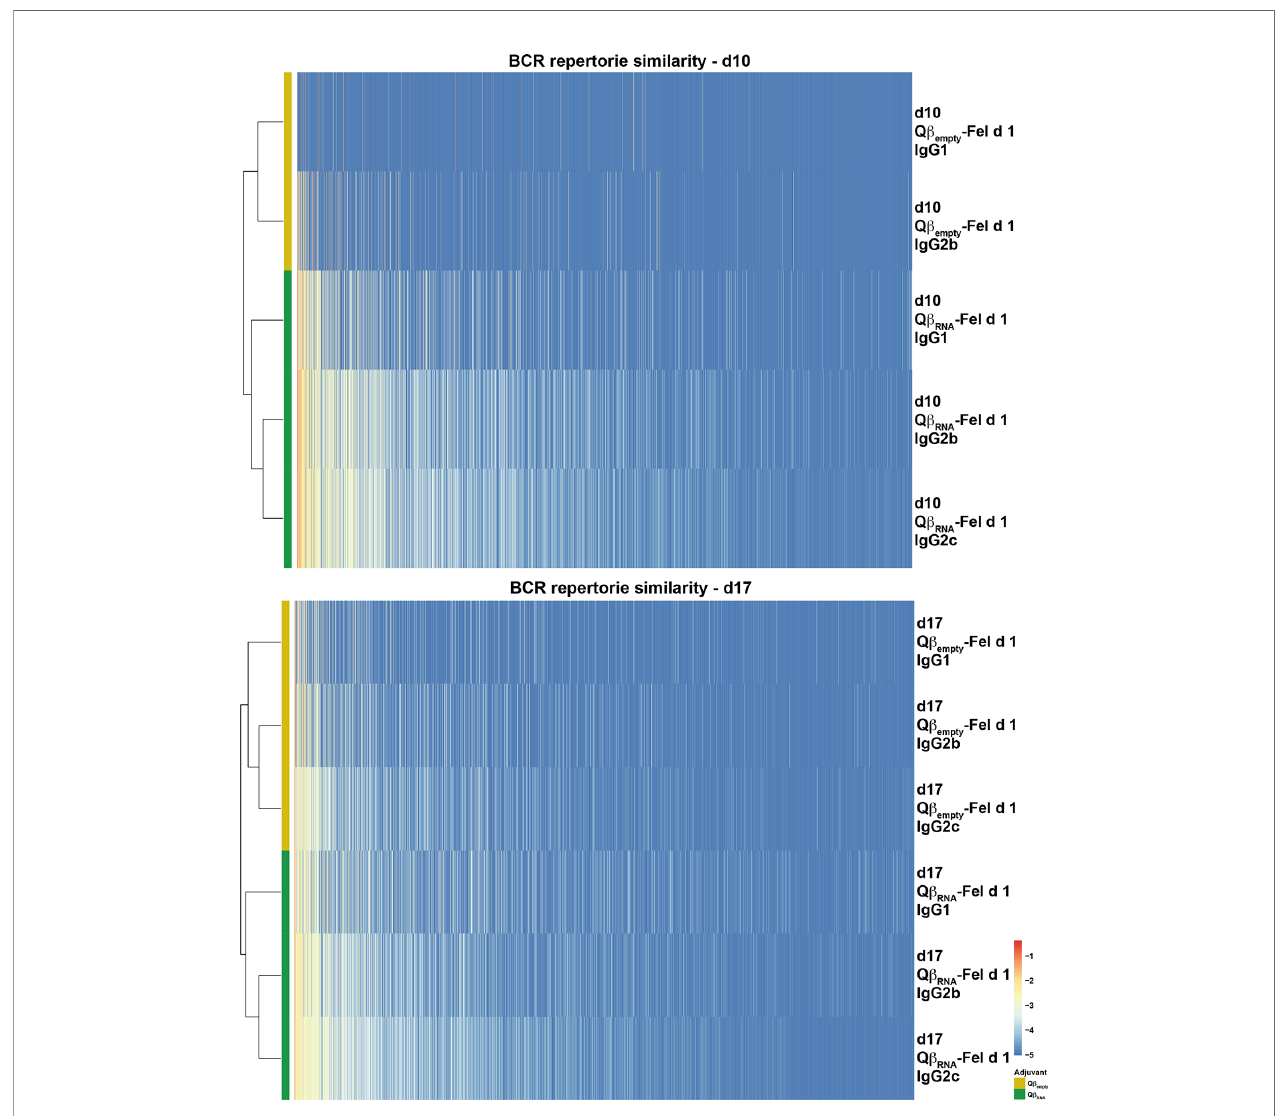
FIGURE 7 | Similarity of Fel d 1-speci fi c IgG BCR repertories at d10 and d17 after immunization. The CDR3 clonotypes were displayed, usage frequency was shown as each colored bar, and the phylogenetic tree was created according to the overall CDR3 sequence similarities among each repertoire. The fi gure is representative of two independent